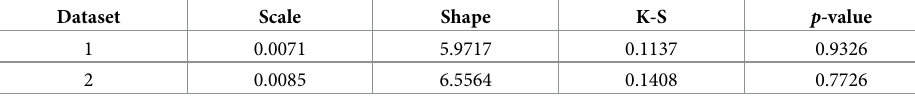
Table 2. The Kolmogorov-Smirnov test output for real datasets.